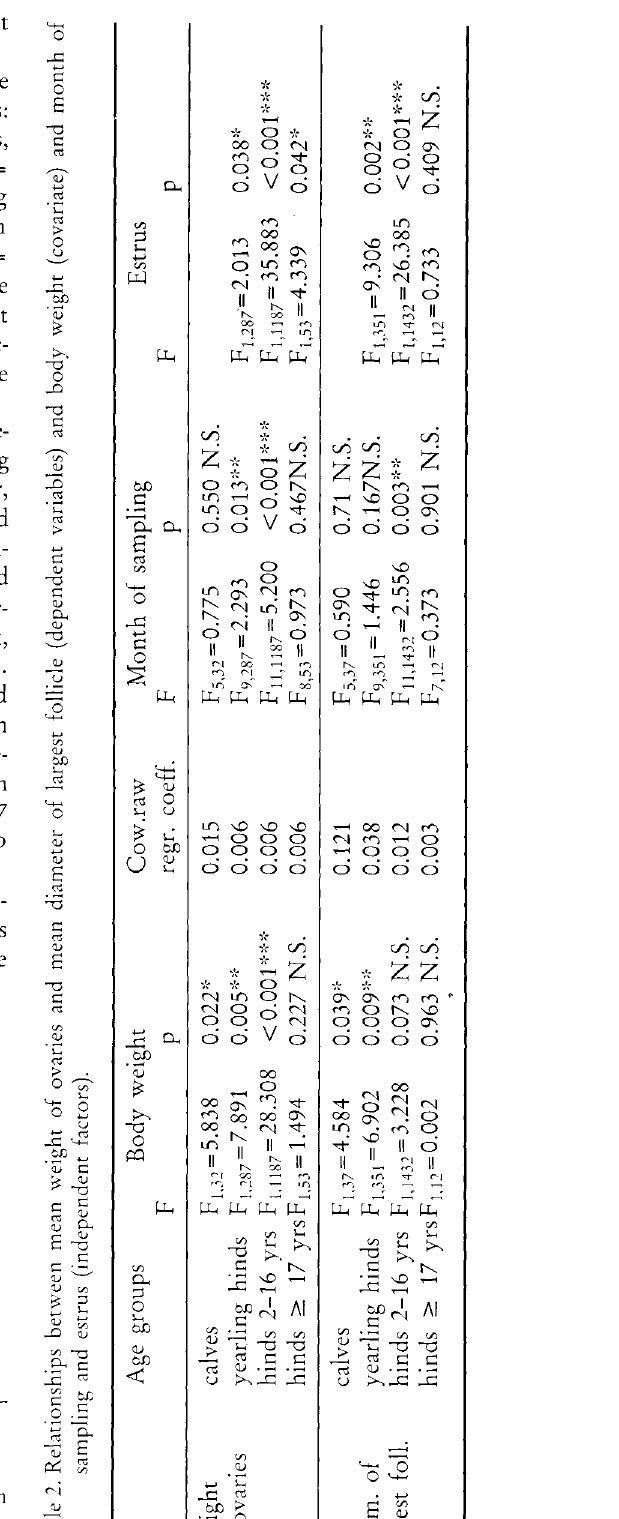
Fig. 5. Mean diameter (± S.D.) of largest follicle in pairs of ovaries from hinds one year and older in different months of the